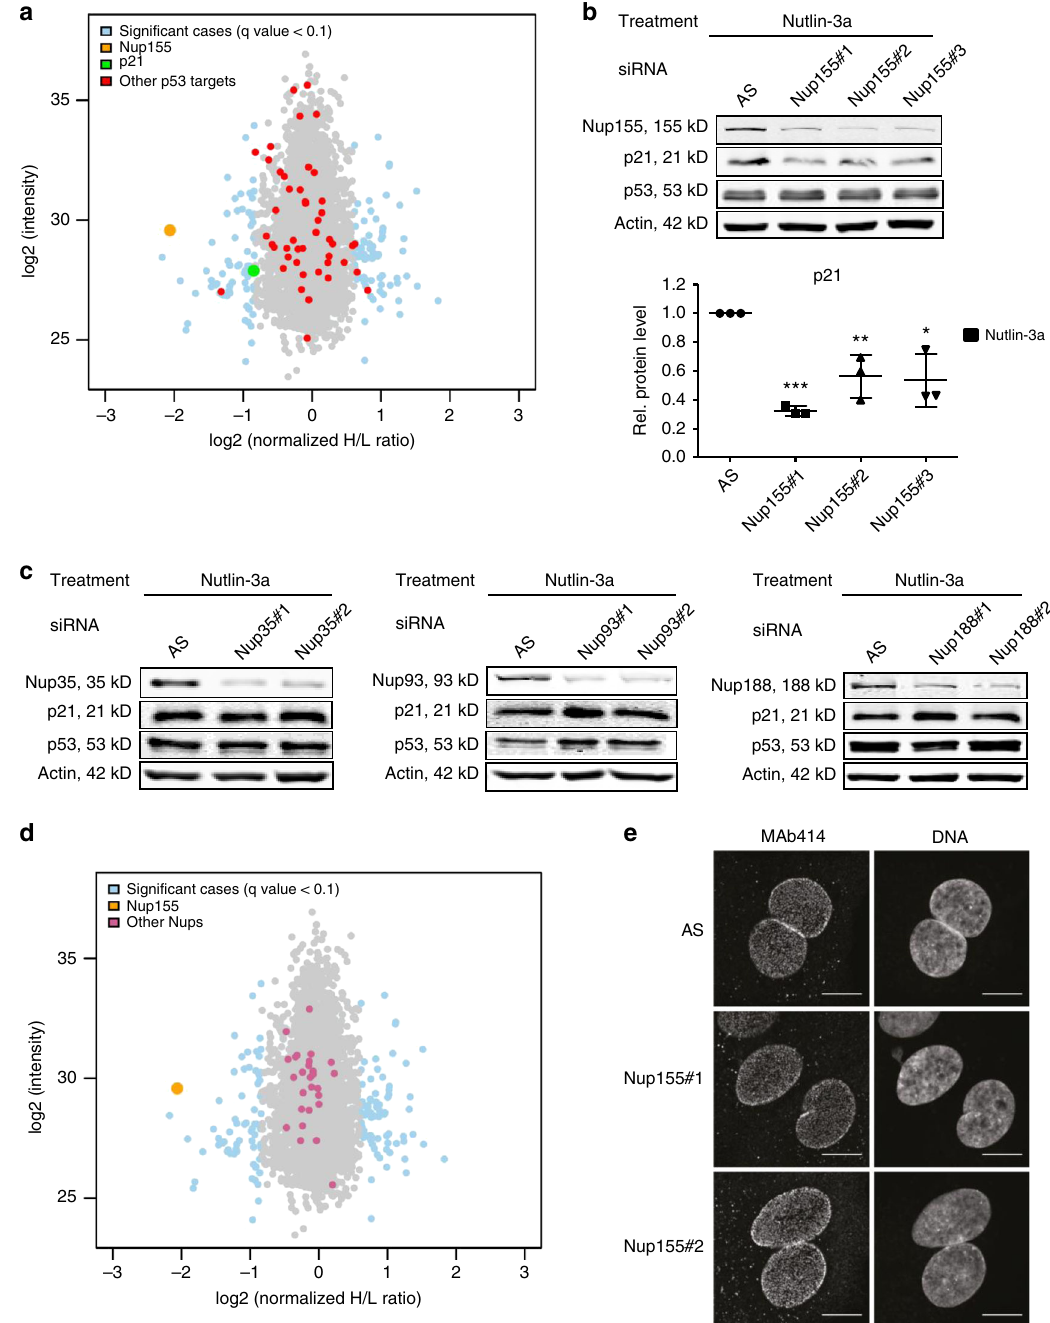
Fig. 1 Full induction of p21 is Nup155-dependent. a Protein fold-changes (blue and grey dots) including p53 targets (red dots) upon Nup155 (orange dot) knockdown compared to the control siRNA (AS) condition are shown as log2 ratios. p21 is highlighted in green as a key effector of the p53 response. Overall 3523 proteins could be quanti fi ed by quantitative mass spectrometry in HepG2 cells treated with Nutlin-3a for 24 h. b HepG2 cells were treated either with control siRNA (AS) or three different Nup155 siRNAs (Nup155#1, Nup155#2, and Nup155#3) for 72 h and p53 was induced by adding Nutlin-3a for 24 h. Cell extracts were analysed by immunoblotting with indicated antibodies (upper panel). Densitometric quanti fi cation of immunoblots derived from three independent experiments is shown in the lower panel and normalised to the control siRNA (AS) condition. c HepG2 cells were treated either with control siRNA (AS) or two different Nup35, Nup93, and Nup188 siRNAs (Nup35#1, Nup35#2, Nup93#1, Nup93#2, Nup188#1, and Nup188#2) for 72 h. Cells were harvested upon 24 h of Nutlin-3a treatment and extracts were analysed by immunoblotting with the indicated antibodies. For corresponding densitometric analyses see Supplementary Figure 1B-D. d Protein fold-changes of NPC components (purple dots) upon Nup155 knockdown (orange dot) corresponding to the conditions described in a . e Representative confocal microscopy pictures of MAb414 immuno fl uorescence staining of HepG2 cells treated as indicated. DAPI was used for DNA labeling. Scale bar = 10 µ m. * p < 0.05, ** p < 0.01, *** p < 0.001 (Student ′ s t -test). Data are presented as mean ± stdv. Source data are provided as a Source Data fi